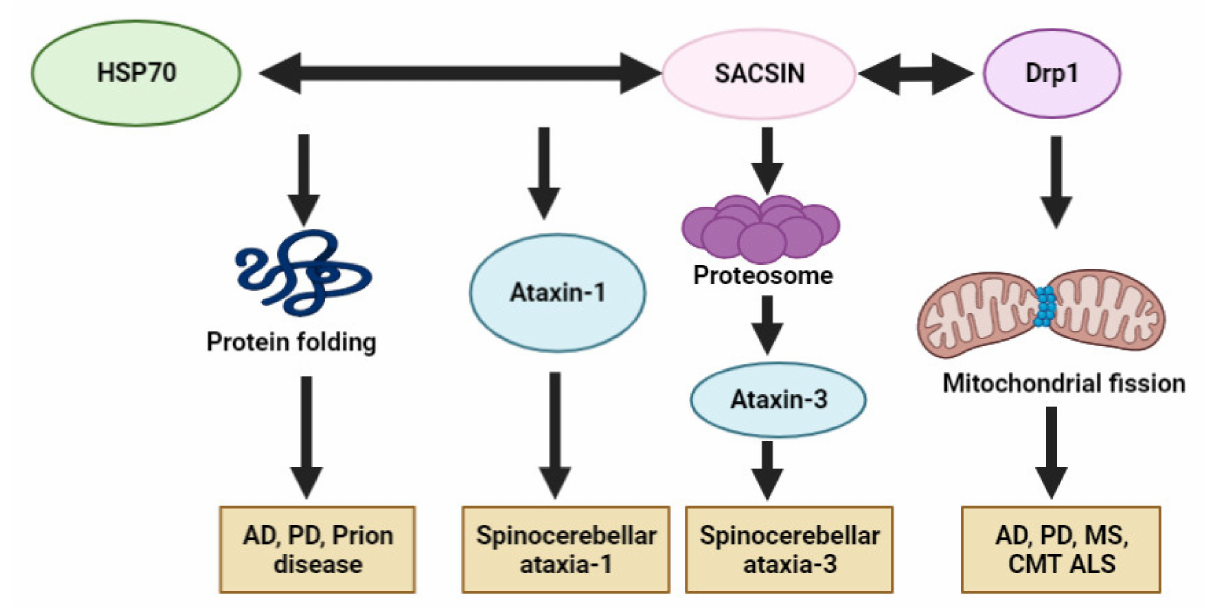
Figure 5. Possible disease mechanisms of sacsin protein in other neurodegenerative diseases: AD, PD, MS, CMT, ALS, SCA and